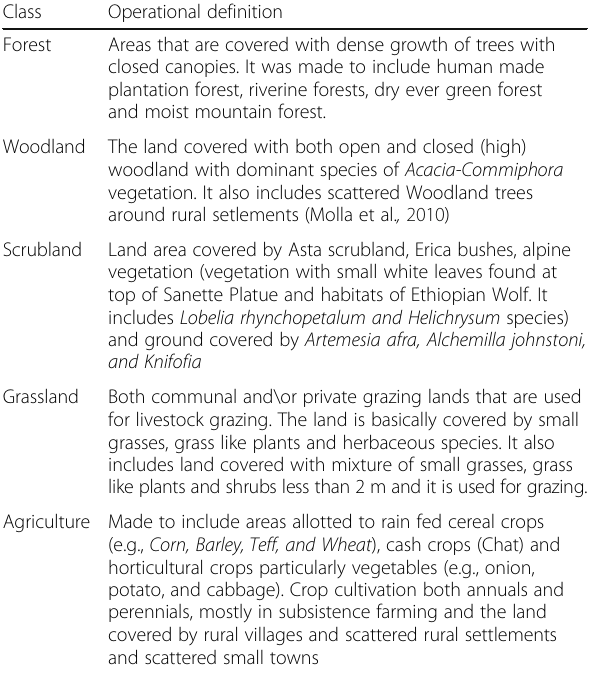
Table 2 Operational definition of landscape classes at BER